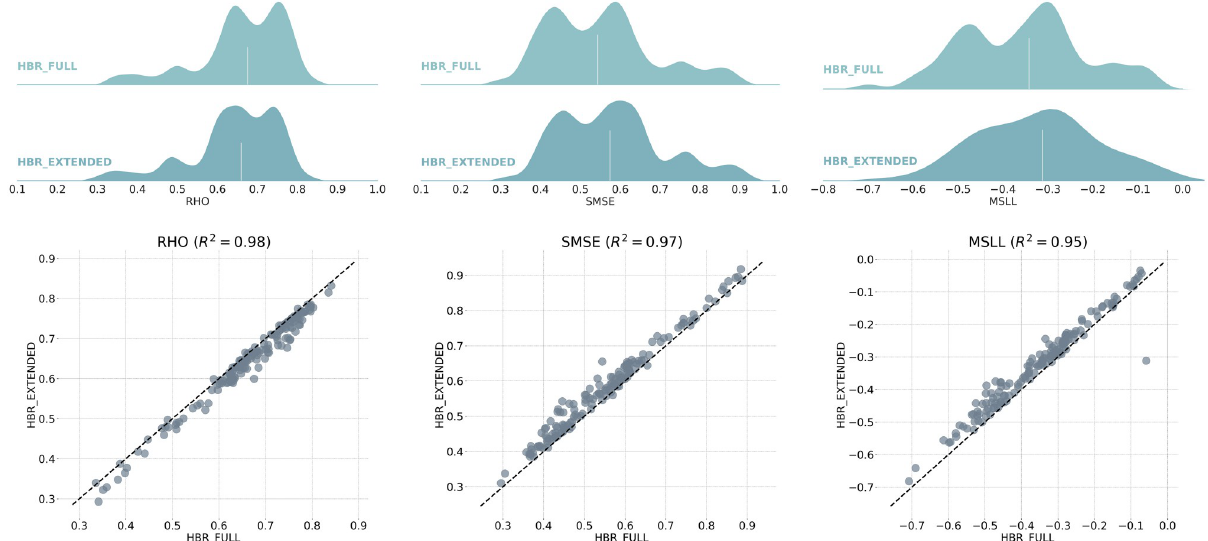
Fig 9. Comparison between the regression performance of HBR when trained on centralized data (HBR-FULL) versus decentralized model development using model extension strategy (HBR-EXTENDED). The ridge plots show distributions of correlation, SMSE, and MSLL across 148 cortical areas. As depicted in the scatter plots, HBR-EXTENDED models show very similar RHO ( R 2 = 0.98), SMSE ( R 2 = 0.97), and MSLL ( R 2 = 0.95) compared to HBR-FULL models trained on full data in one run.